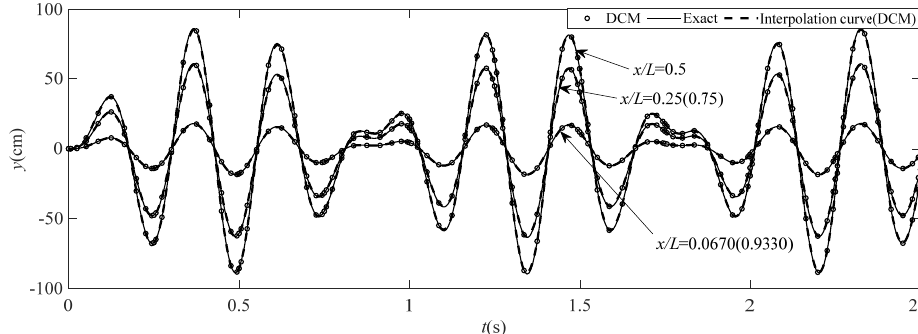
Figure 7. Time-history displacement of beam midpoint (T = 2.5 s).